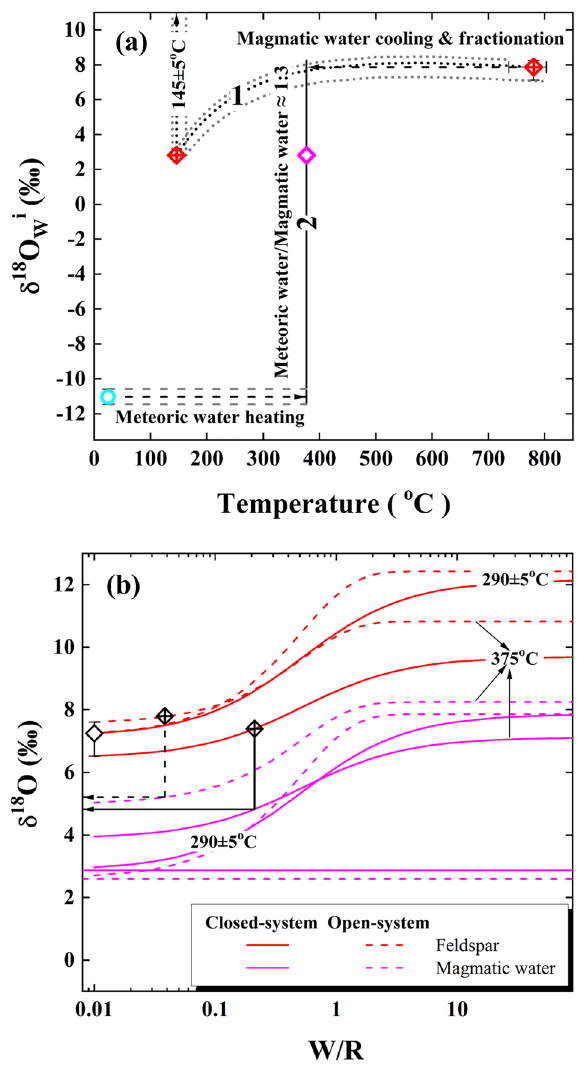
Figure 5. Diagrams of oxygen isotopic evolution. ( a ) Line 1 with gray envelopes denotes thermodynamic fractionation of the primary magmatic water in the course of cooling, whereas line 2 illustrates a binary mixing between the cooled magmatic and heated meteoric water under an isothermal condition. The oxygen isotopes of primary magmatic water are constrained by the observed zircon δ 18 O values of the Tianzhushan granitoid pluton at corresponding magmatic temperatures (Table S1), whereas those of the meteoric water are adopted from sample 01HP05 (Table 1) and reasonably assumed to be applicable on the orogenic scale. ( b ) Final δ 18 O values of alkali feldspar and magmatic water after interacting with each other at labelled temperatures. The initial δ 18 O values of alkali feldspar are calculated with the observed zircon δ 18 O values on the pluton scale, whereas those of primary magmatic water refer to ( a ). Horizontal lines illustrate the maximum variability of δ 18 O i W values of the evolved magmatic water theoretically inverted from sample 02TZ01 (Table 1, Figs. 4b,e). Data points on the red curves denote the increased δ 18 O values of alkali feldspar observed from the Tianzhushan pluton (Table S1), whereas arrowed lines illustrate the corresponding oxygen isotopes of the magmatic water after exchanging with alkali